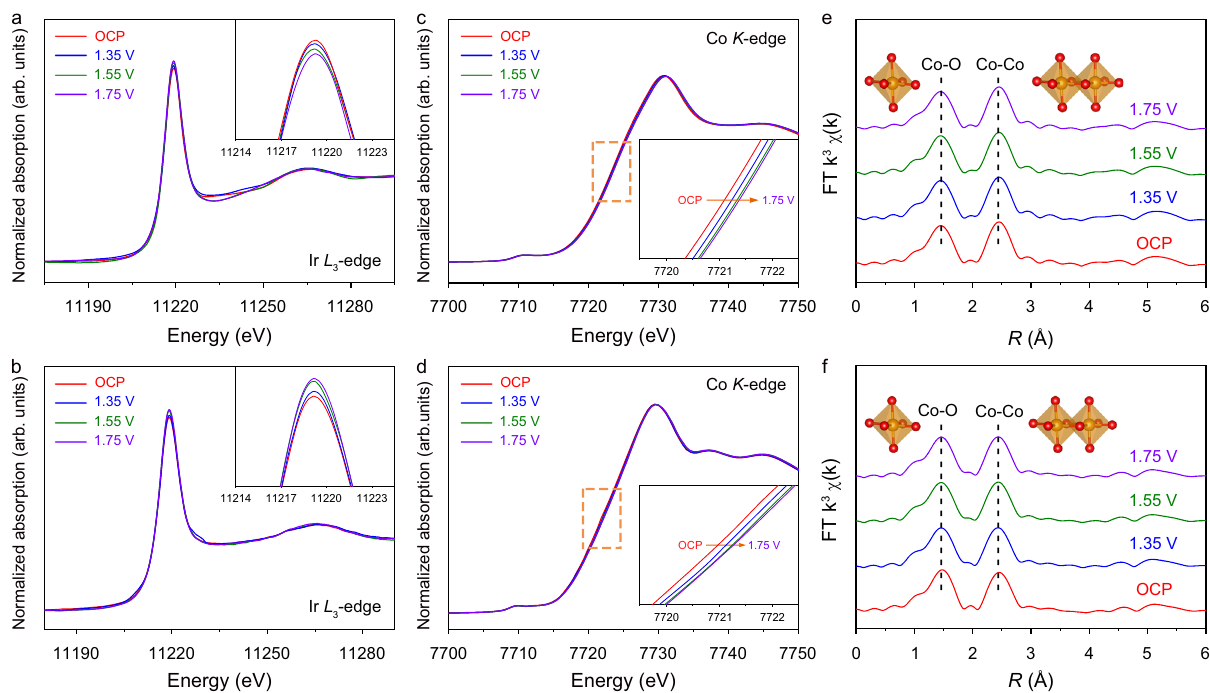
Fig. 4 In-situ spectroscopic characterizations of Ir 1 /T O – CoOOH (top) and Ir 1 /V O – CoOOH (bottom). a , b In-situ Ir L 3 -edge XANES spectra of Ir 1 /T O – CoOOH ( a ) and Ir 1 /V O – CoOOH ( b ) at different applied potentials. The inset is the magni fi ed spectra at the white line peak. c , d In-situ Co K -edge XANES spectra of Ir 1 /T O – CoOOH ( c ) and Ir 1 /V O – CoOOH ( d ) at different applied potentials. The inset is the magni fi ed spectra at the adsorption